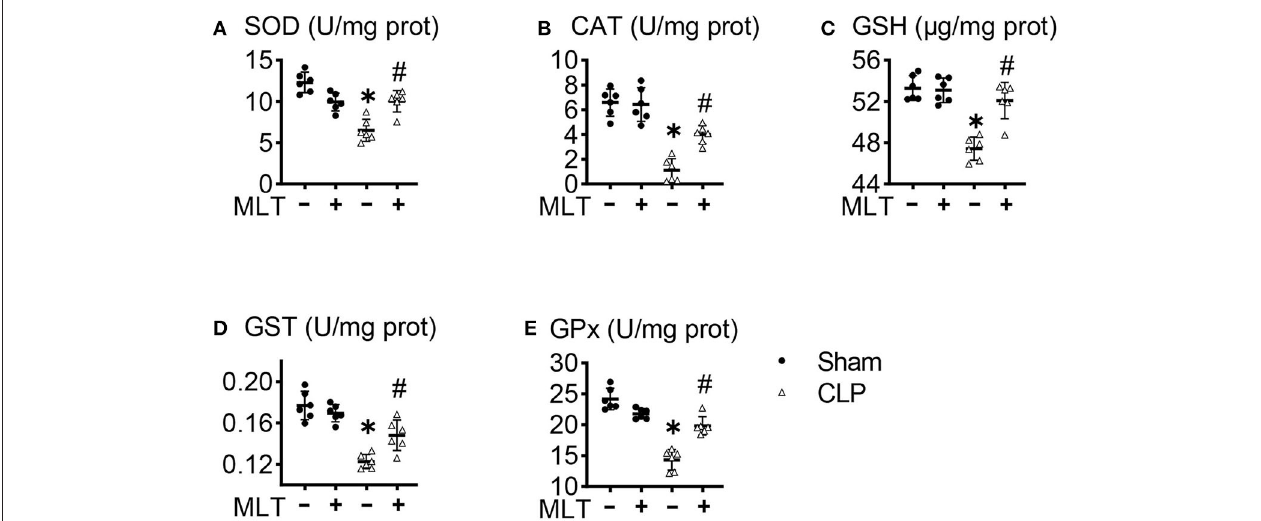
FIGURE 4 | Melatonin modulates mitochondrial antioxidant status in the heart after CLP. Effects of MLT on the cardiac mitochondrial antioxidant levels of superoxide dismutase (SOD) (A) , catalase (CAT) (B) , glutathione (GSH) (C) , glutathione s-transferase (GST) (D) , and glutathione peroxidase (GPx) (E) . Values are presented as means ± SD, *vs. sham, p < 0.05; # vs. CLP, p <